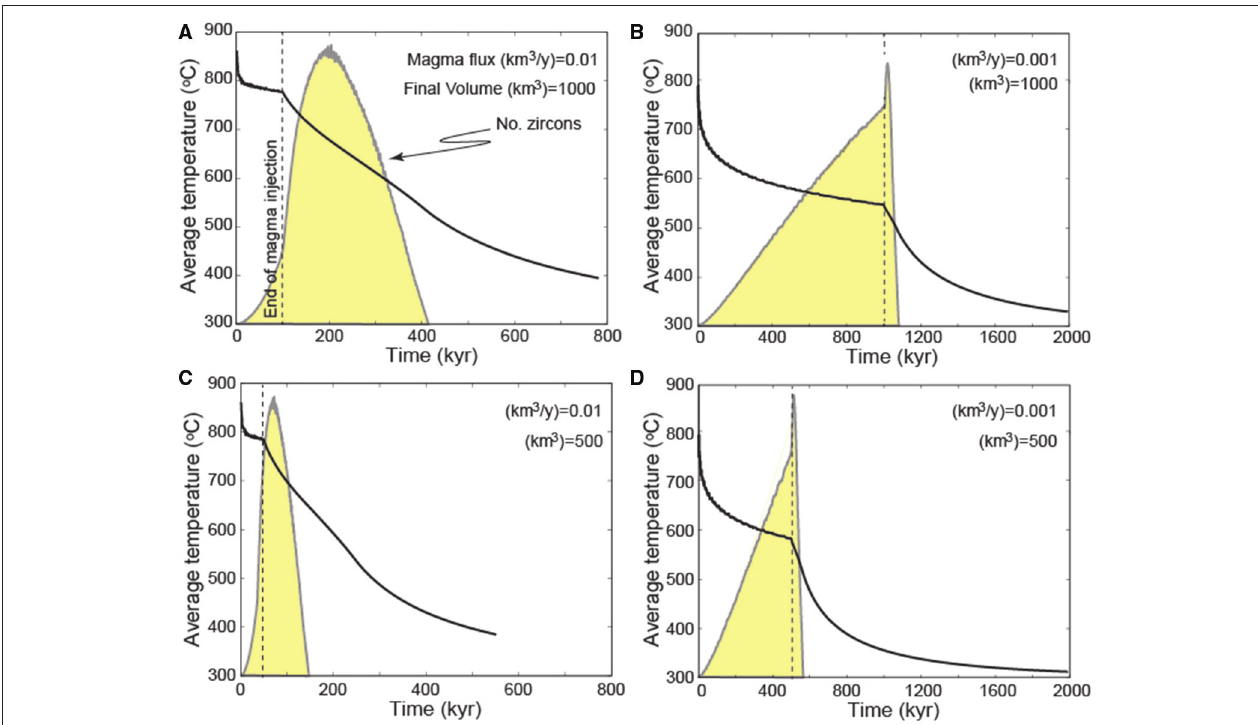
FIGURE 4 | Combined temporal evolution of the average temperature of the intrusion and resulting population of zircon crystallization times. The shape of the zircon crystallization time population reflects the evolution in time of the relative volume of magma within the range of zircon saturation temperature. The modeled final volumes were 500 and 1000km 3 for (C,D) and (A,B) , respectively.